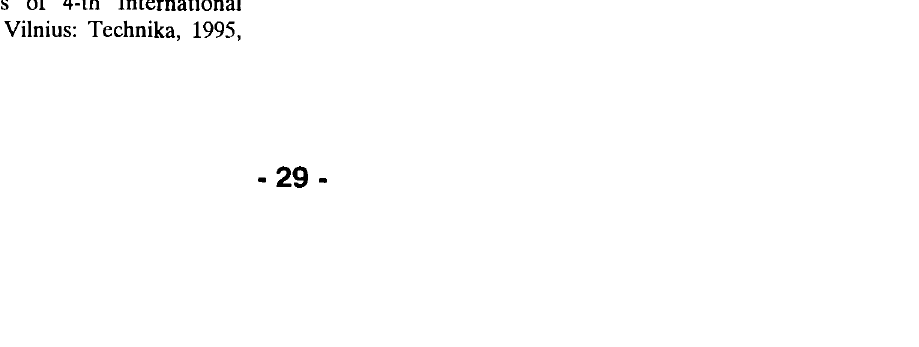
structures, computer simulation and design of reinforced concrete structures, renovation of